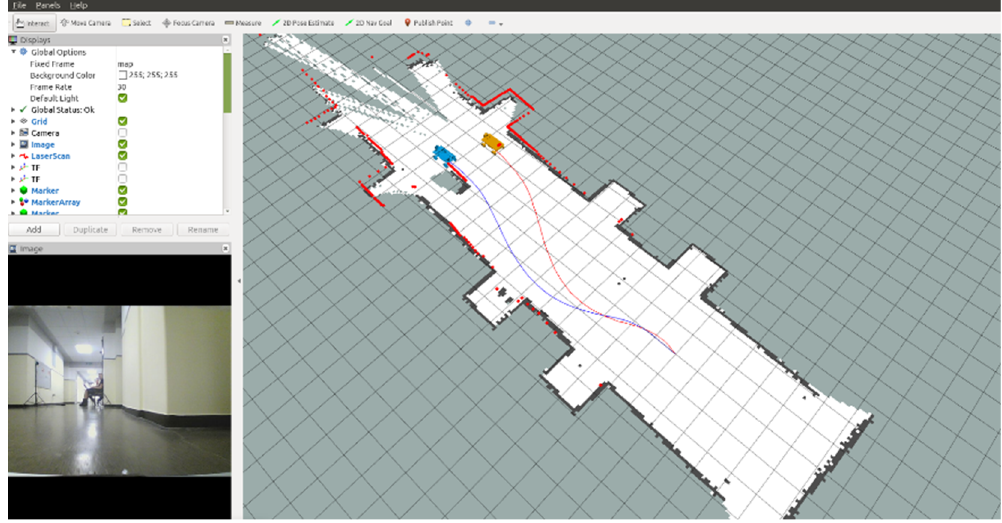
Figure 11. The comparison of SLAM (blue path) and dead reckoning (red path).